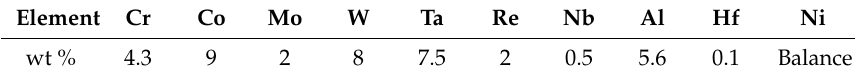
Table 1. Nominal chemical composition of DD6